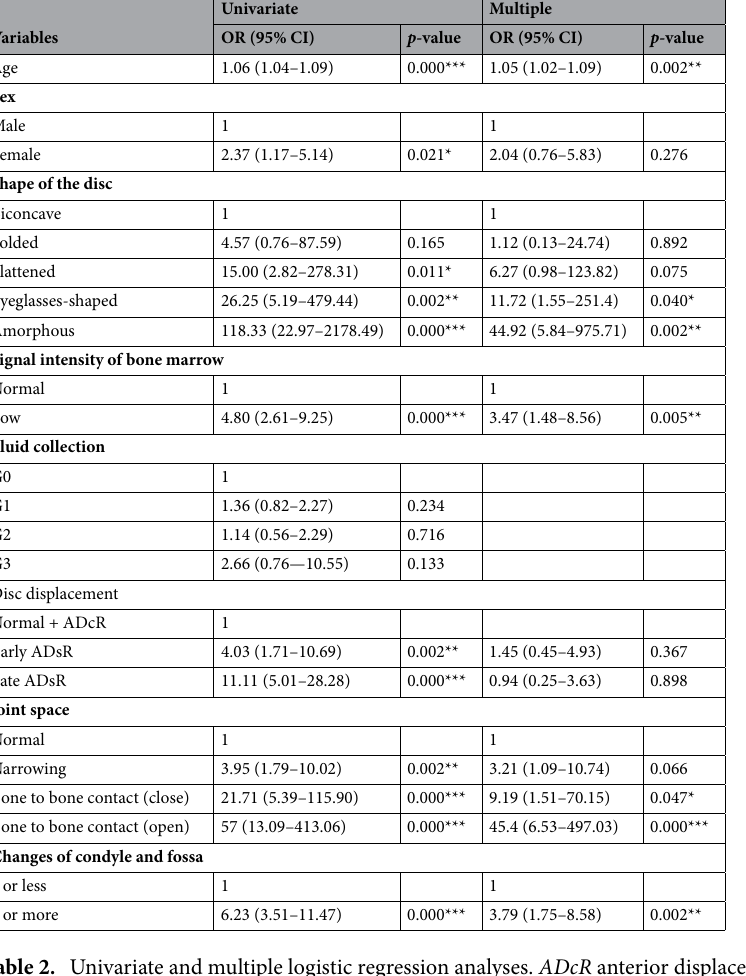
Table 2. Univariate and multiple logistic regression analyses. ADcR anterior displacement with reduction, ADsR anterior displacement without reduction. * p < 0.05, ** p < 0.01, *** p <